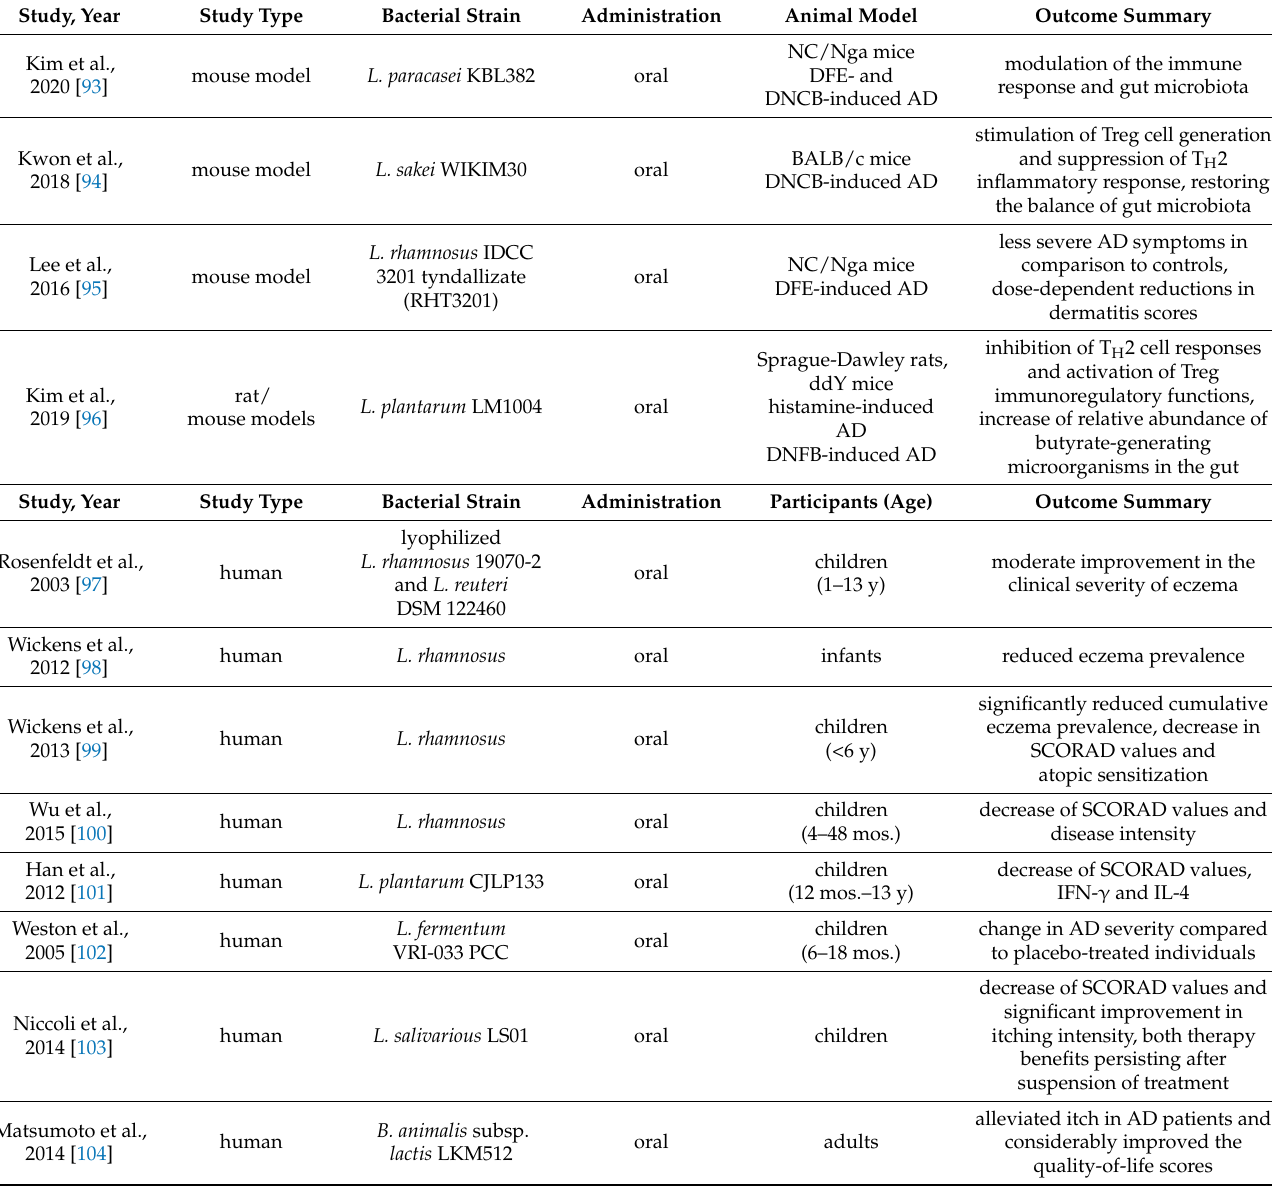
Table 1. Studies using probiotics and prebiotics in management of